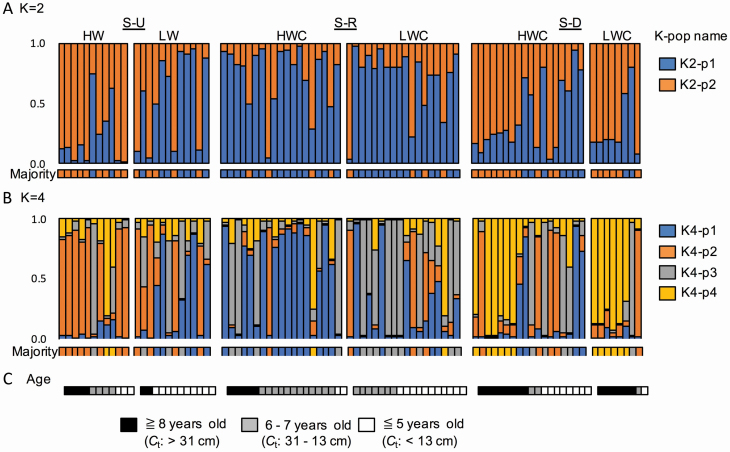
The result of Bayesian clustering analysis (A, B) and the age of each individual (C). Samples are sorted on the basis of whether they come from HWC (left) or LWC (right) areas. Individuals are subsequently sorted by their the 120 cm high circumference of trunk (Ct). Each upper rectangle, containing coloured vertical lines, indicates each individual’s proportion of assignment to each of K populations (K = 2 and 4, in A, B) based on hierarchical Bayesian clustering analysis. Each lower rectangle indicates the majority of K-pop (in A, B).